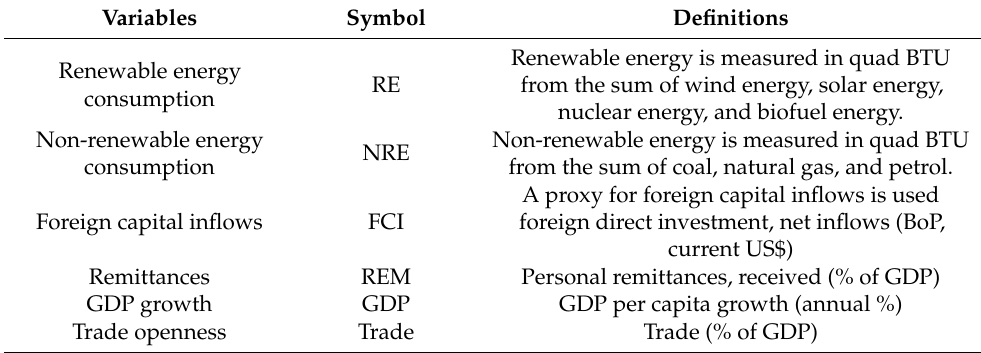
Table 1. Variables